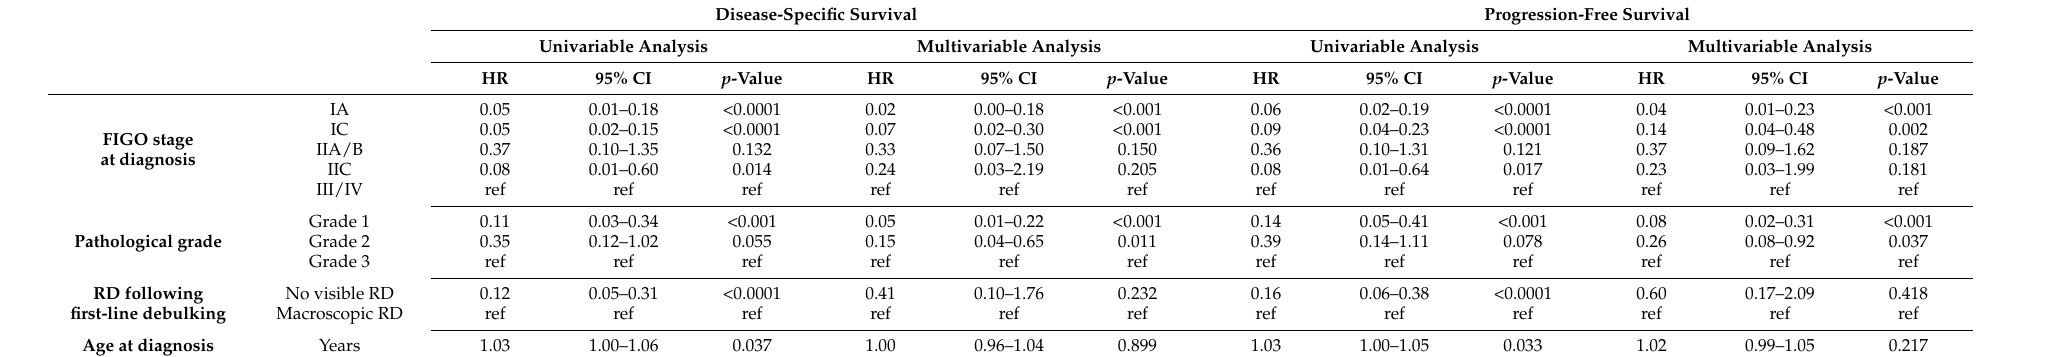
Table 2. Survival analysis of mucinous ovarian carcinoma